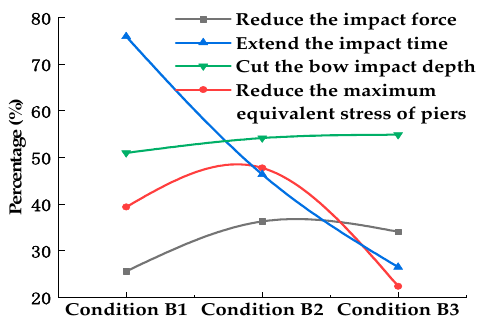
Figure 24. Collision avoidance performance of the device under different wall thickness.